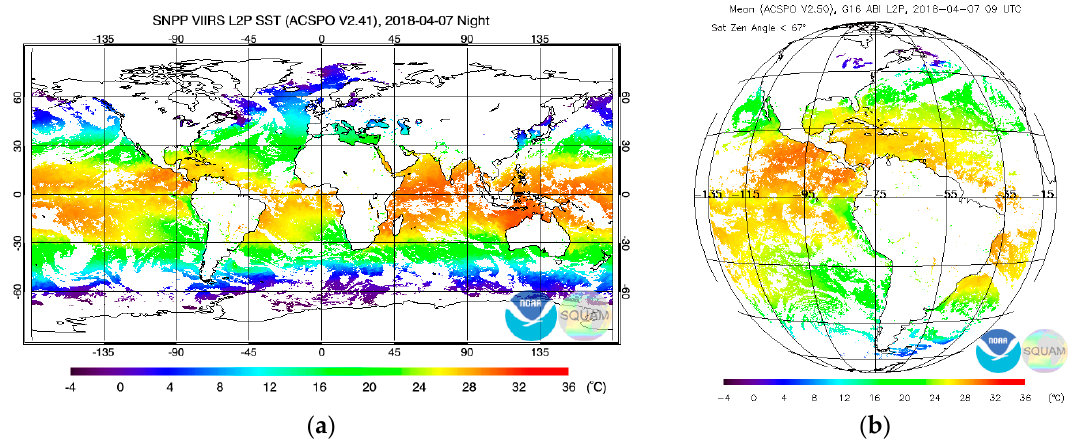
Figure 1. Composite maps of nighttime sea surface temperature (SST) retrieved with Advanced Clear-Sky Processor for Oceans (ACSPO on 4 April 2018 from ( a ) polar-orbiting Suomi National Polar-Orbiting Partnership Visible and Infrared Imager/Radiometer Suite (SNPP VIIRS) and ( b ) GOES-16 Advanced Baseline Imager (ABI) (the latter taken at 9:00 UTC). Both images are from the NOAA SST Quality Monitor (NOAA SQUAM) [35,36].